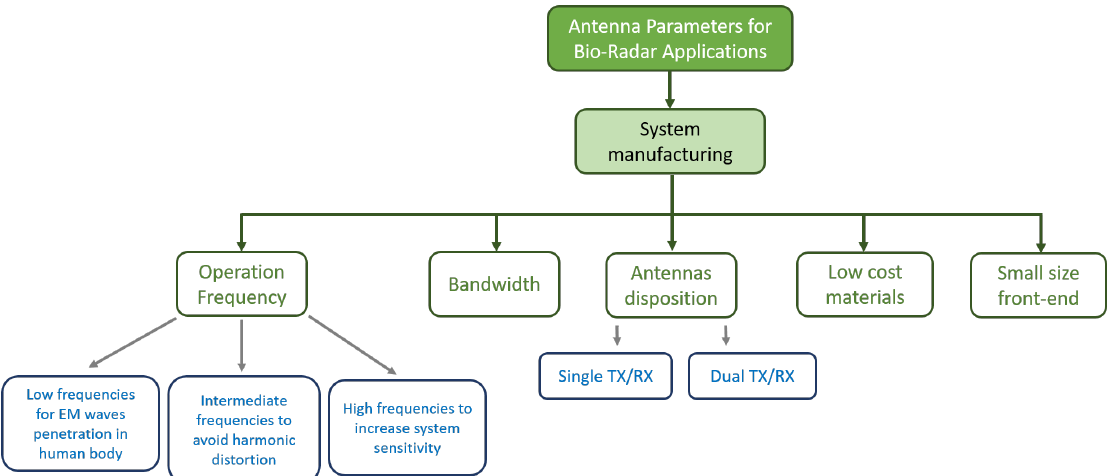
Figure 3. Antenna parameters to consider for manufacturing